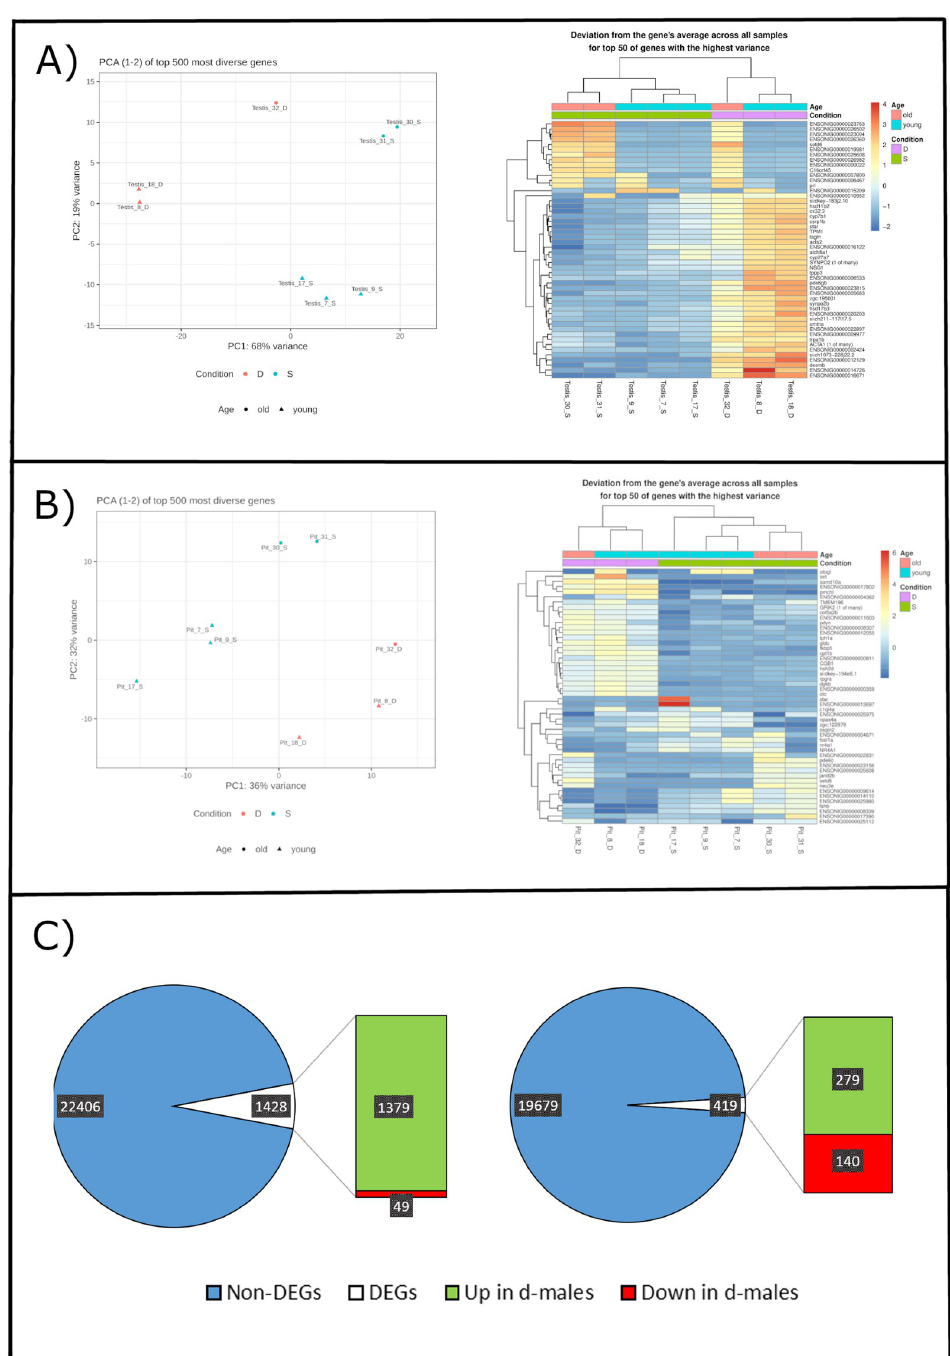
Fig 3. Gene expression profiles of testes and pituitaries from dominant and subordinate Nile tilapia show differences between tissues and social groups. ( A ) and ( B ): PCA plots for DEGs in testes (A) and pituitaries (B) show a clear line of division between dominants and subordinate fish. PCAs were computed based on normalized and log- transformed counts of the top 500 variable genes. A second line could be drawn between family 3 (34 months) and the families 1 and 2 (nine to twelve months). Heatmap clustering for the 50 genes with the highest variance in testes (A) and pituitaries (B) based on normalized and log-transformed counts. ( C ): Numbers of genes sequenced in testes and pituitaries and DEGs used for functional annotation. DEG were defined when the fold change between s-males and d- males had an adjusted p-value of < 0.05.